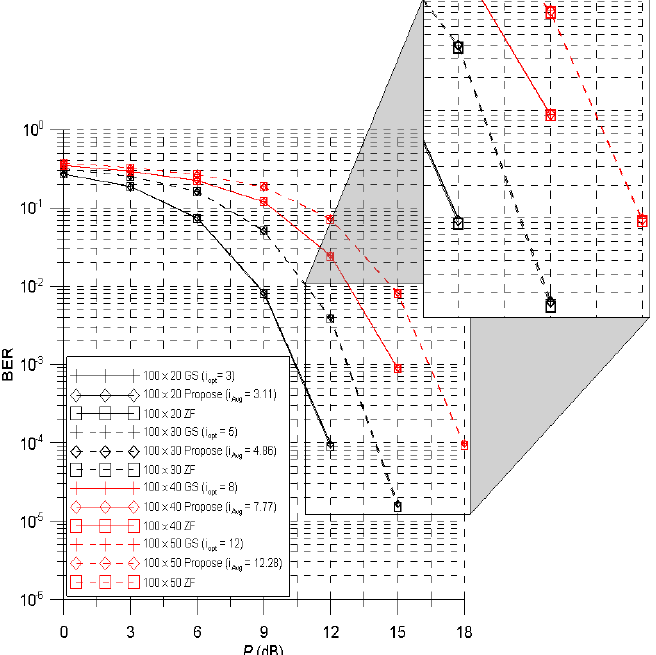
( ) 0 s and 16-QAM is used. ( 0 ) Diag and 16-QAM is used. Appl. Sci. 2020 , 10 , x FOR PEER REVIEW Diag